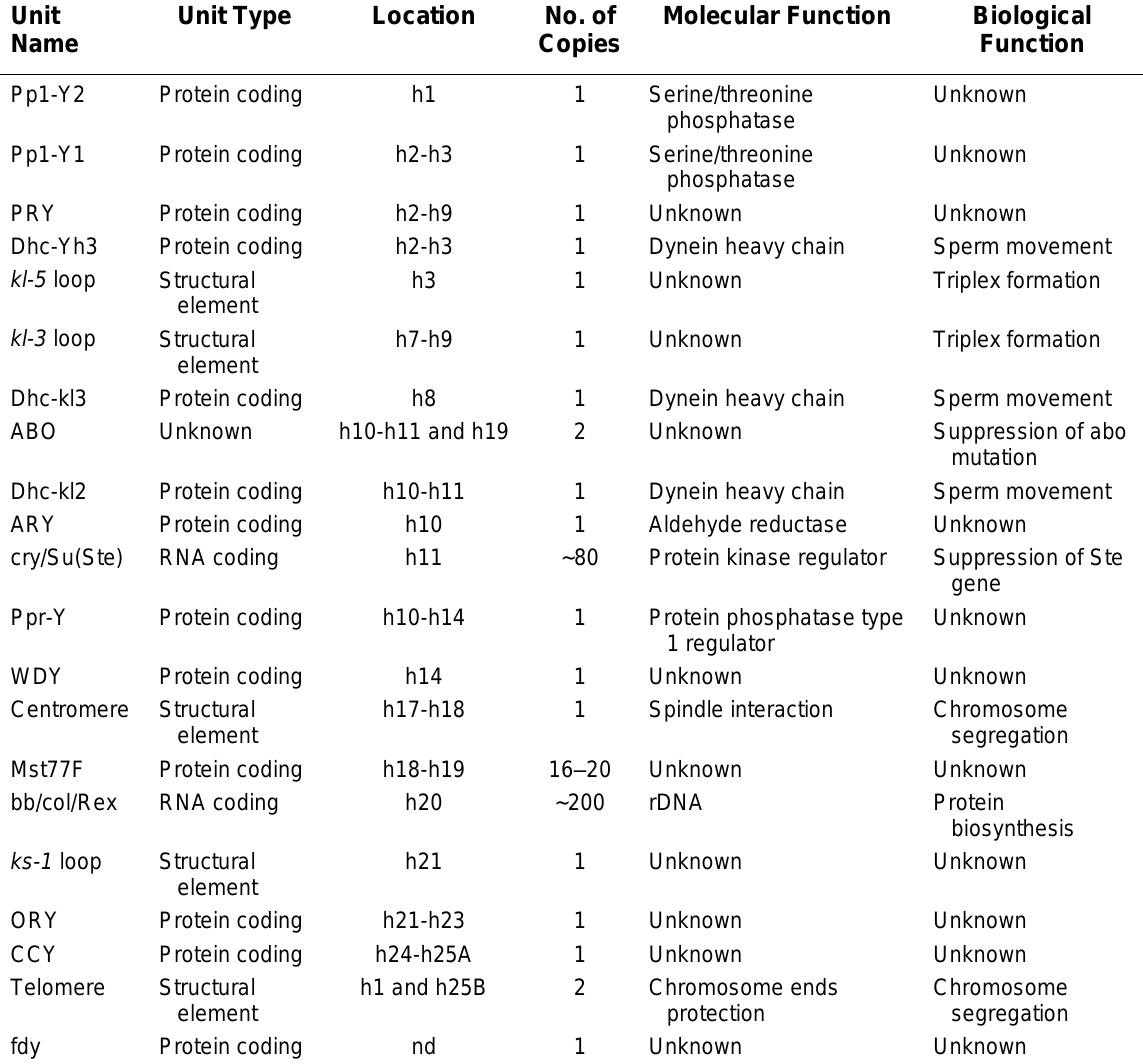
Summary of the “L ocatable Units of Inheritance ” Mapping on the Y Chromosome*